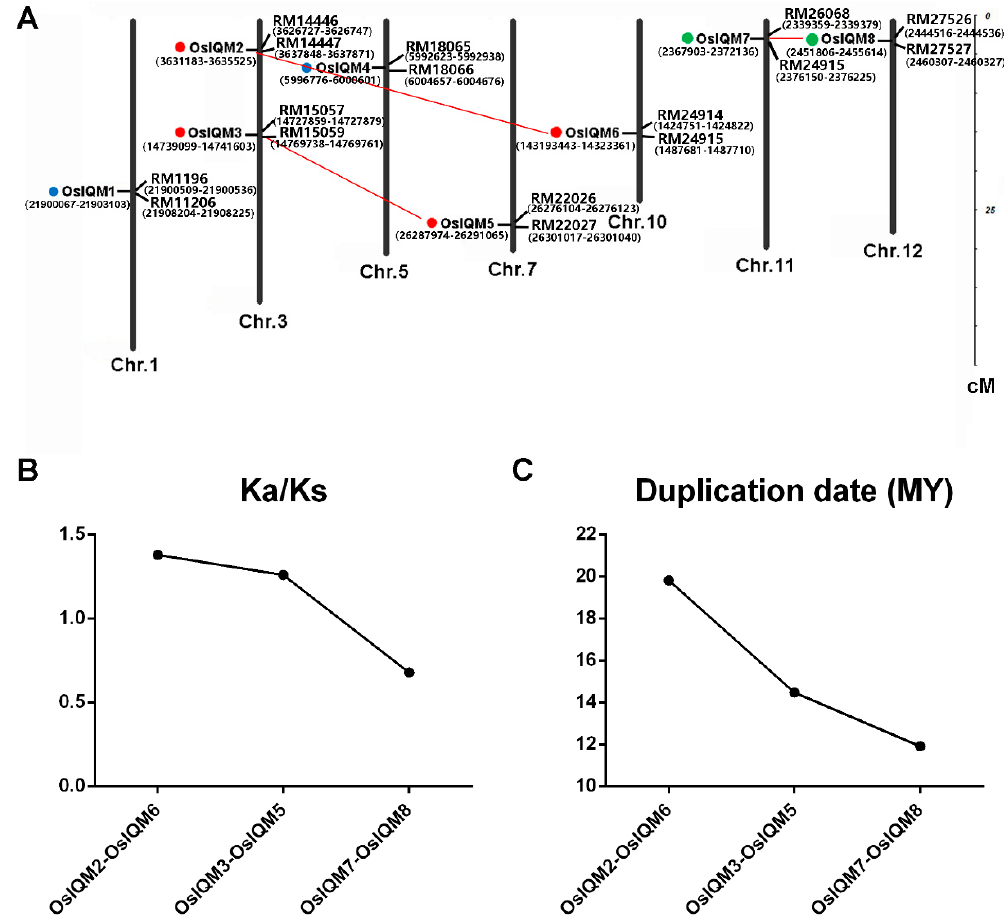
Figure 4. Chromosomal distribution and segmental duplication events of IQM genes in rice. ( A ) Eight OsIQM genes are mapped to 7 of the 12 rice chromosomes. The nearest SSR markers of eight OsIQM genes were mapped to 7 rice chromosomes. The duplicated paralogous pairs of OsIQM genes were connected with red lines. Chromosome numbers were located at the bottom of each vertical bar. Different colored circles on the left of the gene name represented corresponding subfamily which this gene belongs to. Red—subfamily I; blue—subfamily II; green—subfamily III. ( B , C ) Distribution of Ka/Ks values ( B ) and duplication date (MY) ( C ) were obtained from paralogous gene-pairs in the rice genome.